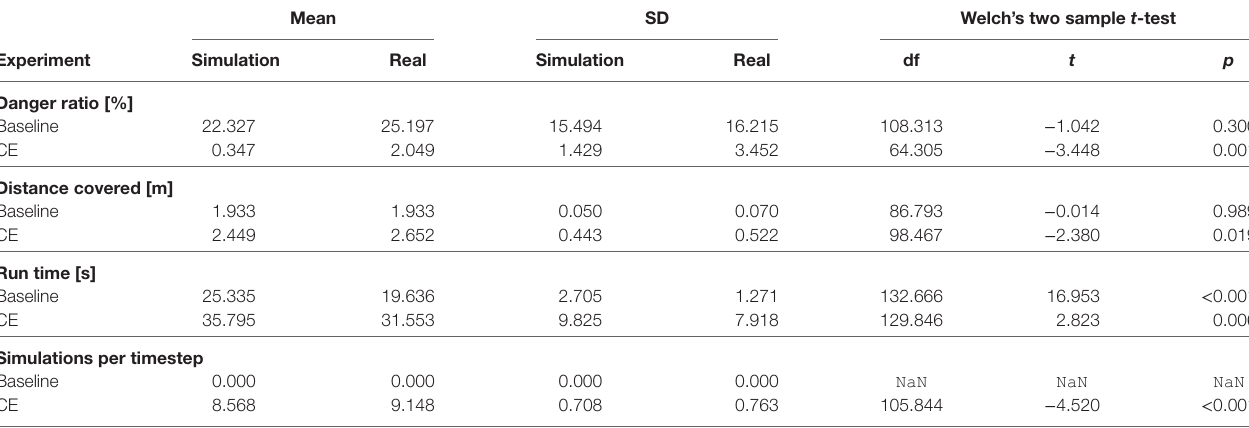
TaBle 2 | Shown are test statistics for the Welch’s two sample t -test testing for differences between real experiment and simulation for all measured